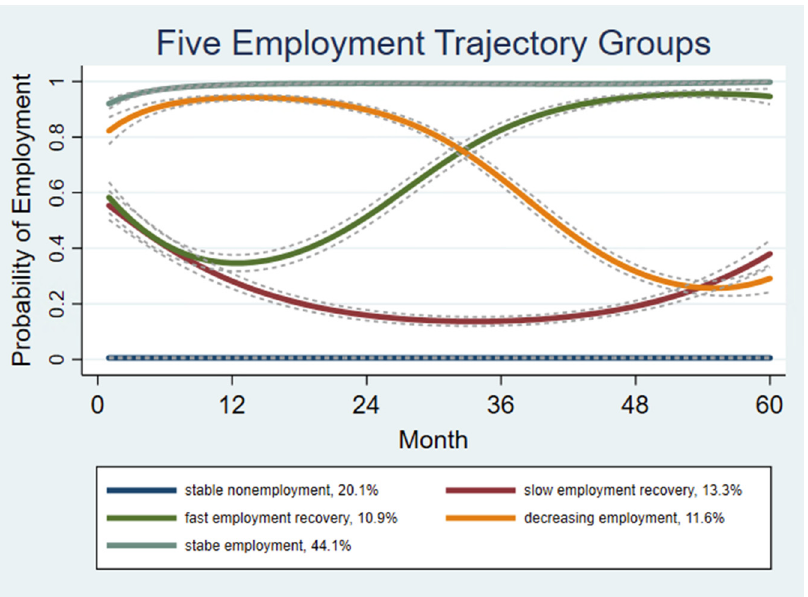
Figure 2. Five Employment Trajectory Groups. Notes. 1. The solid lines represent the predicted probability of employment status over time for the five employment trajectory groups; the dashed lines represent the 95% confidence intervals of the predicted probabilities. 2. The x -axis represents time in months during the five-year study period from mid-2008 to mid-2013, and the y -axis represents the predicted probability of employment.